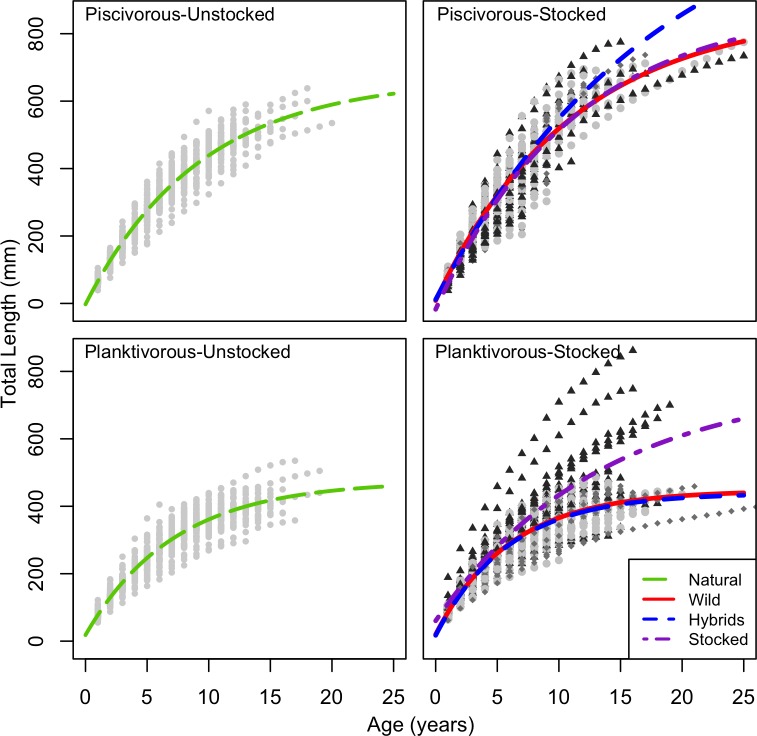
Individual growth curves by genetic origin within pooled unstocked and stocked populations of both ecotypes.Length-at-age of natural and local (light gray circles), hybrid (dark gray diamond) and stocked (black triangles) Lake Trout. Curves are global Von Bertalanffy growth models by genetic origin.